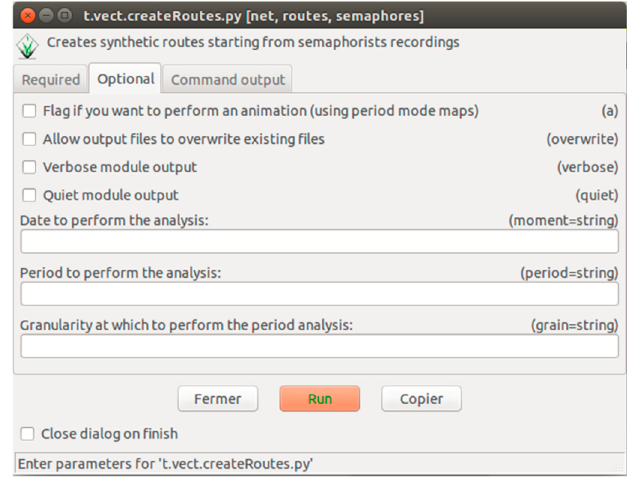
Figure 10. Temporal requirements in the graphical interface of t.vect.createRoutes.py.